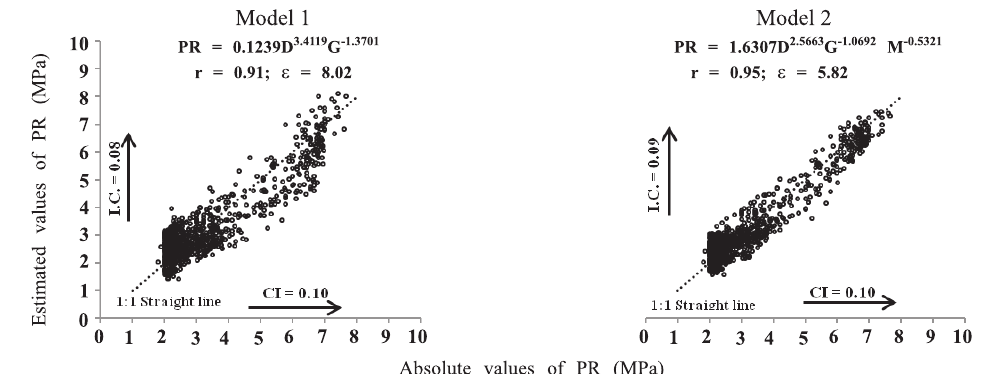
figure 1. absolute (real) and estimated values for soil penetration resistance (Pr) in eutroferric red oxisol (latossolo Vermelho eutroférrico) under annual no-till cropping. r: coefficient of correlation; ε : mean absolute relative error; ci: confidence interval (95